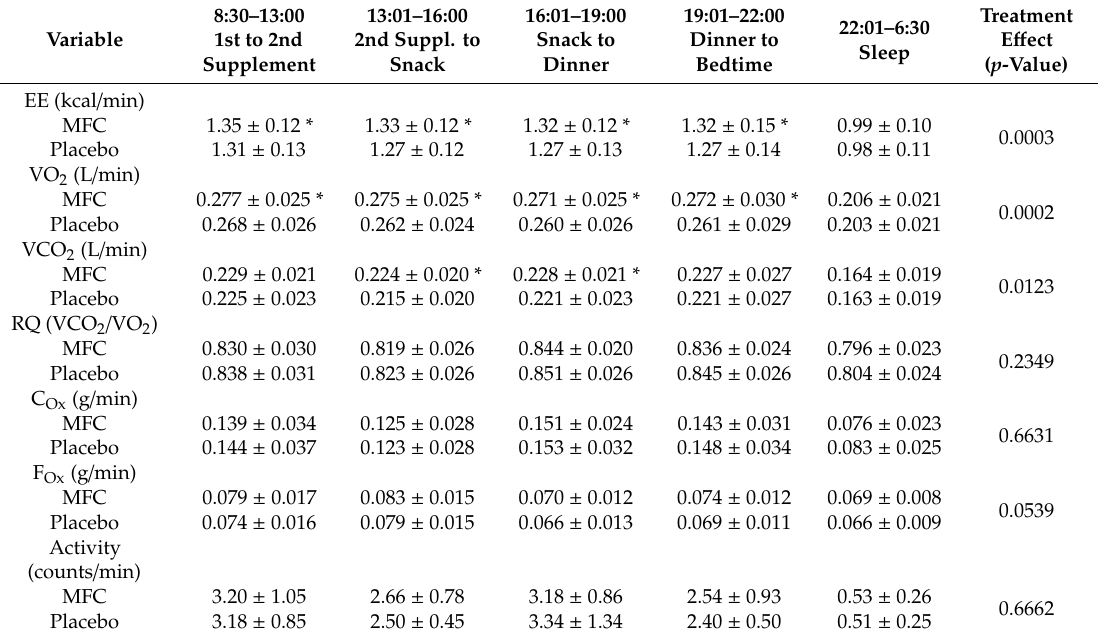
Figure 2. Energy expenditure (kcal / h) for the MFC and placebo trials ( n = 19) (mean ± SD) (treatment e ff ect, p = 0.001). Supplements were ingested at 8:30 (hour 1) and 13:00 (hour 5). Breakfast, lunch, and dinner were served at 9:00 (hour 1), 13:30 (hour 5), 18:30 (hour 10), respectively. Lights were turned o ff for sleep at 22:30 (hour 14). Table 1. Average metabolic data (expressed per minute) for the mixed flavonoid-ca ff eine trial (MFC) and placebo trials by each time segment ( n = 19) (mean ± SD).